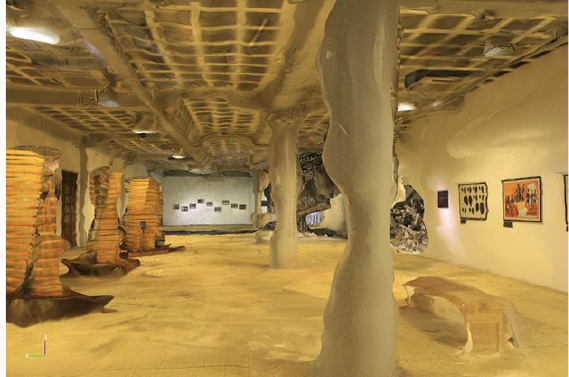
Figure 2. A view along the long axis of the textured model